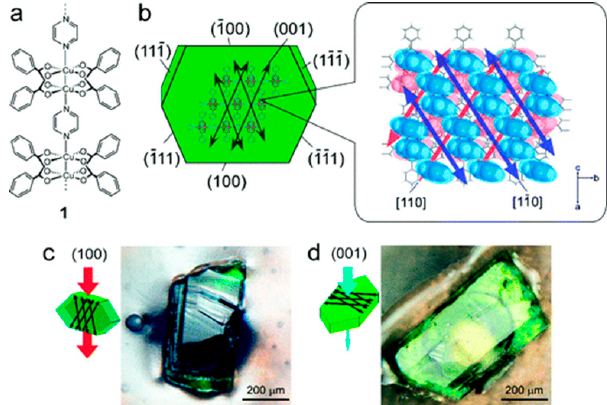
Figure 37. ( a ) Chemical structure and ( b ) crystal structure of [Cu 2 (bza) 4 (pyz)] n (1) showing the determined numbers of the crystal planes and the channel direction. ( c , d ) Photographs of single-crystal membranes of 1: ( c ) exposed (100) crystal surface (channel membrane); and, ( d ) (001) crystal surface (nonchannel membrane) (adapted with permission from ref. [135]).